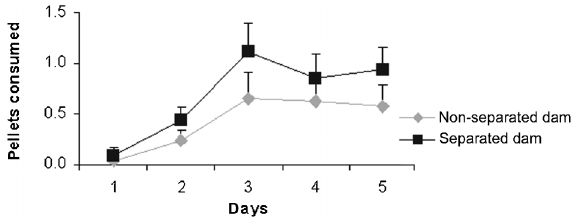
Figure 3. Consumption of sweet pellets during habituation. Data are reported as the mean ± SE number of pellets eaten. Both groups of dams (separated and non-separated) increased sweet food consumption as the days progressed (effect of time, P , 0.0001, repeated measures ANOVA, n = 12-13